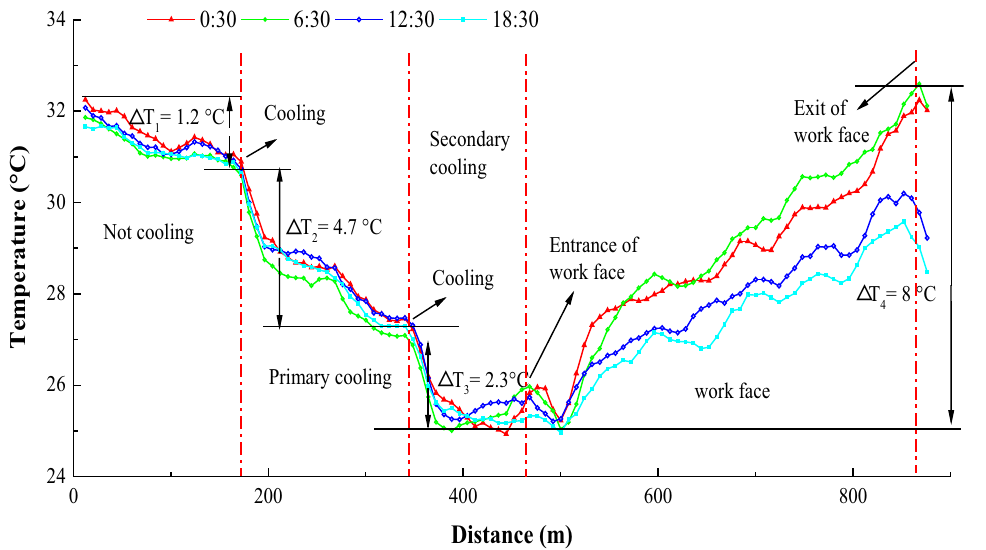
Fig. 7 Daily temperature variation at the working